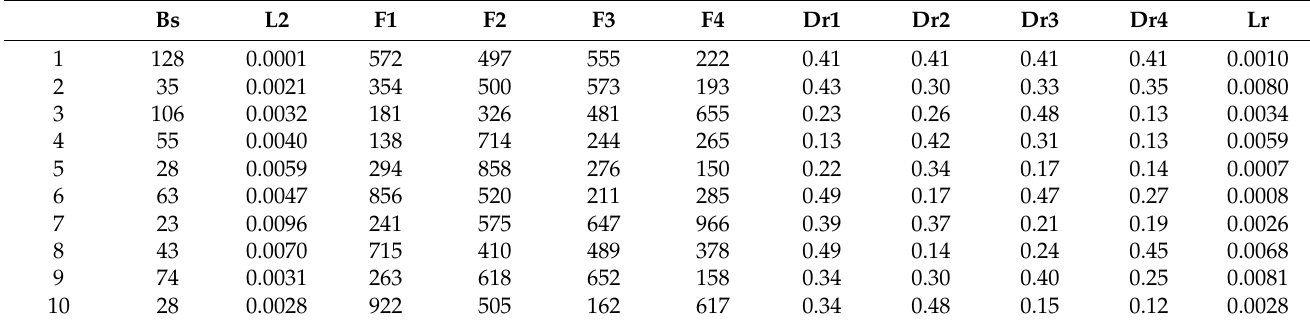
Table 16. Positions of individuals of the HSSA in the experiment on Five